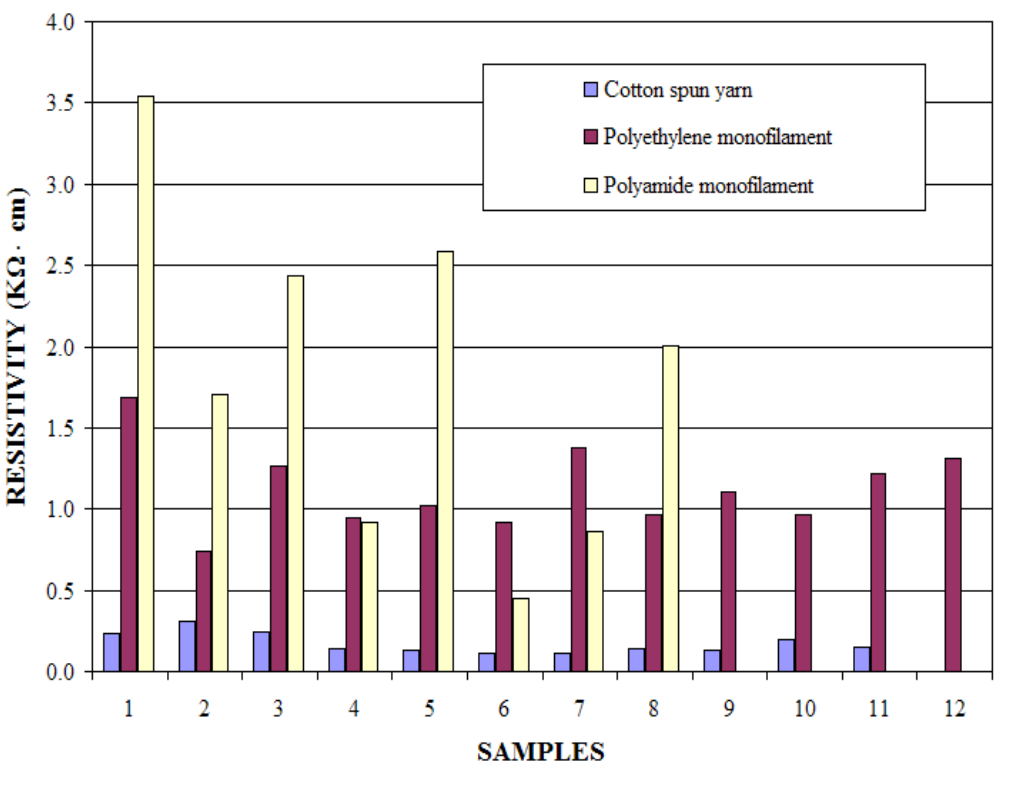
Figure 4. Resistivity values calculated for different substrates coated with 35 wt.-% carbon black